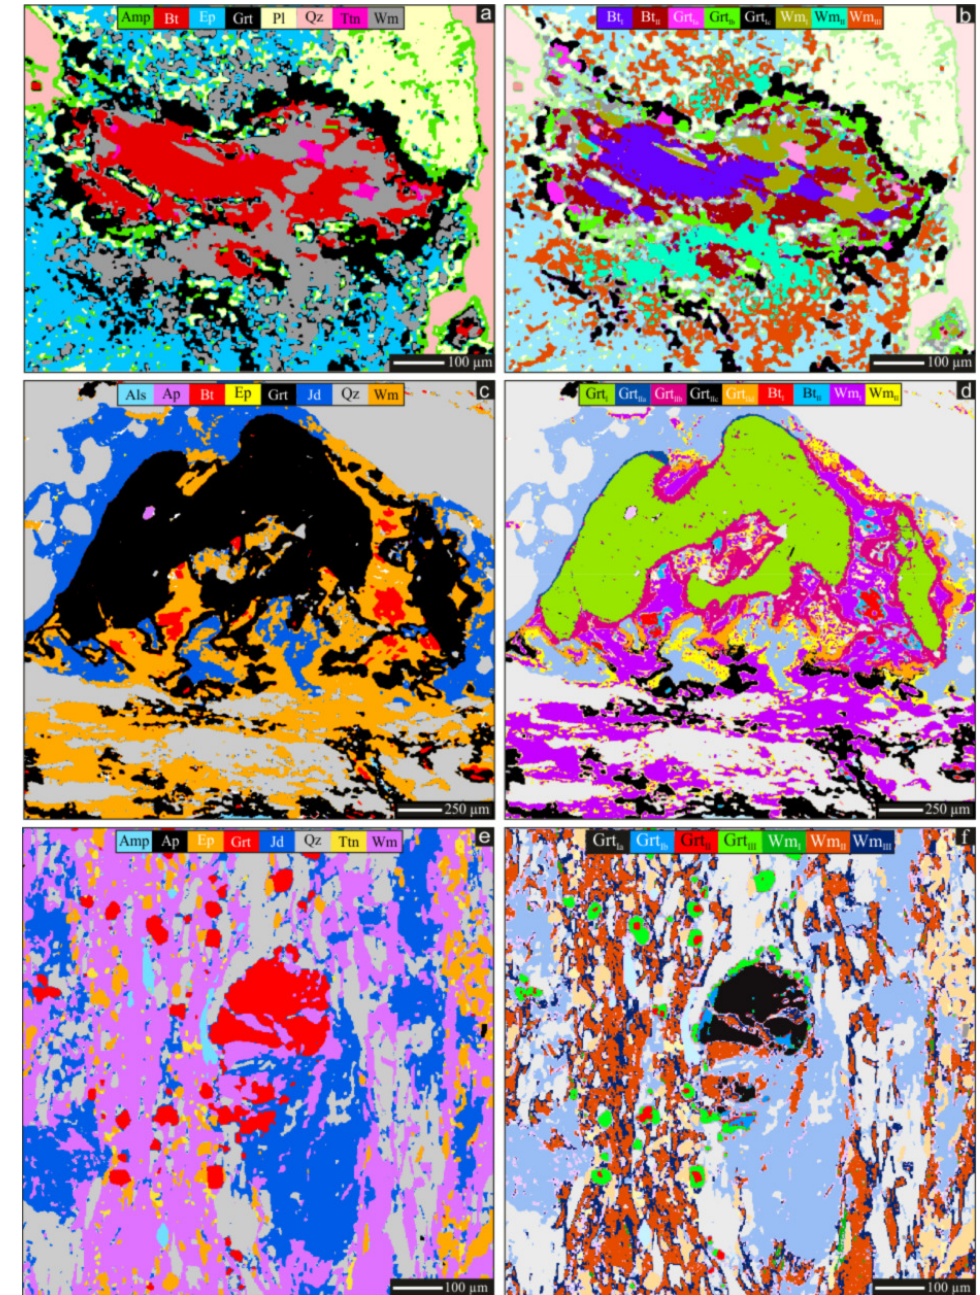
Figure 7. Results obtained with the Q-XRMA classification procedure: ( a , b ) LdV mineral map ( a ) obtained by the first cycle and sub-phase classification of Grt, Bt, and Wm ( b ) obtained by the second cycle; ( c , d ) MM mineral map ( c ) obtained by the first cycle and sub-phase classification of Grt, Bt, and Wm ( d ) obtained by the second cycle; ( e , f ) RCT mineral map ( e ) obtained by the first cycle and sub-phase classification of Grt, and Wm ( f ) obtained by the second